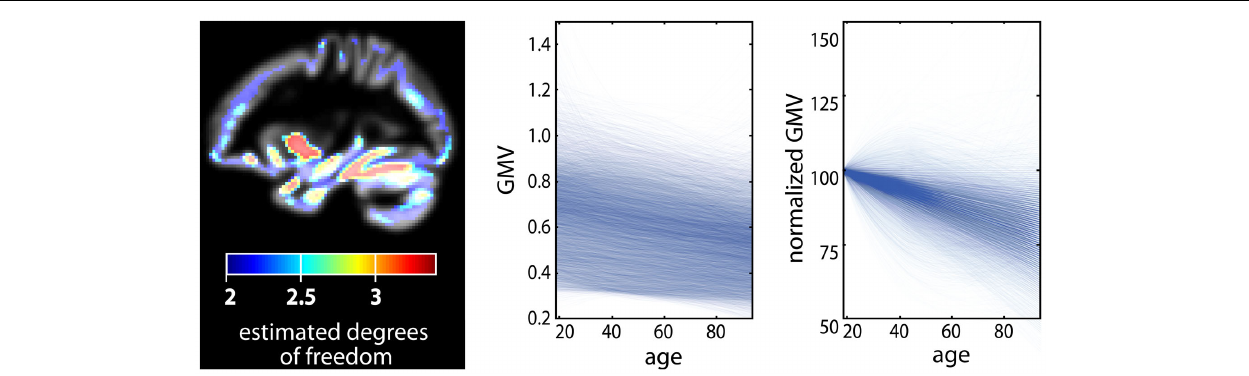
parameter from the interval [1, 1.5].The effective degrees of freedom of the estimated local spline trajectories are depicted (left).The plot shows obtained age trajectories in 10000 randomly selected gray matter voxels (middle).We also show a normalized version of age trajectories using gray matter volume at age 18 as a reference for further lifespan development